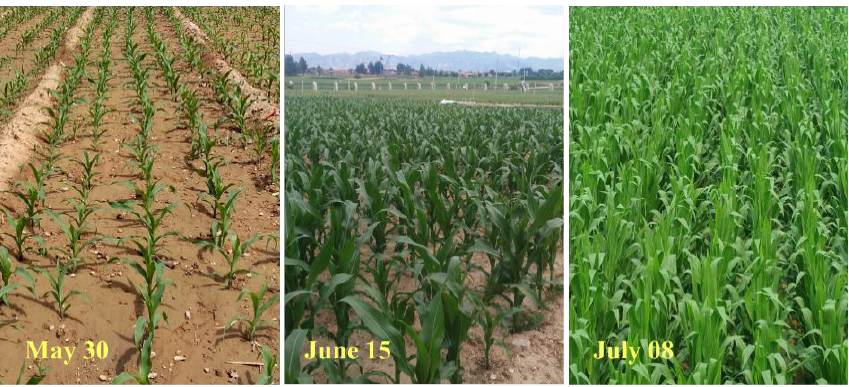
Figure 16. Position and aerial view photograph of the Huailai